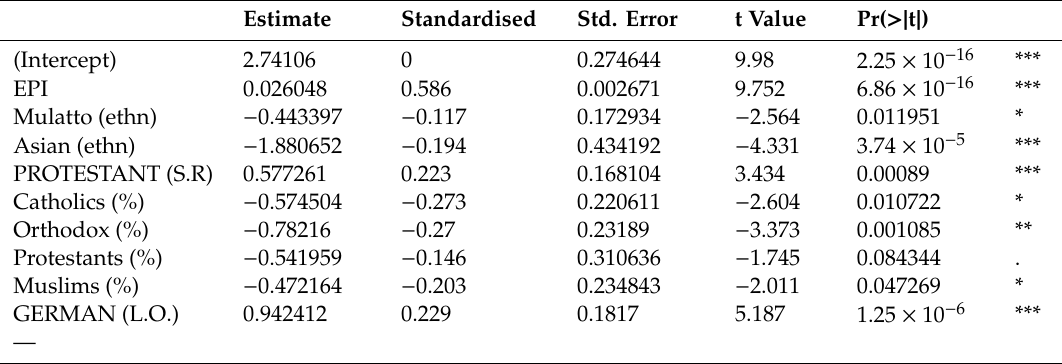
Table 7. Model 1. Competitiveness in the world (Author’s